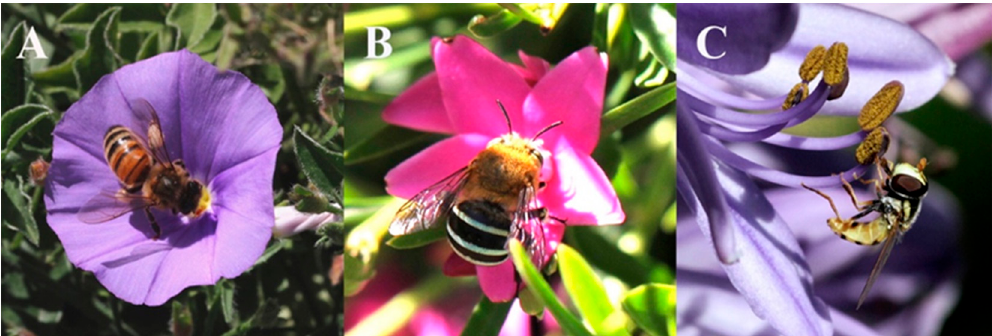
Figure 5 . Colour photographs of flower visiting insects taken nearby the pan trap locations: ( A ) honey ( A ) honey bee ( Apis mellifera ), ( B ) blue-banded bee ( Amegilla sp.), ( C ) hoverfly ( Melagyna sp.). bee ( Apis mellifera) , ( B ) blue-banded bee ( Amegilla sp.), ( C ) hoverfly ( Melagyna sp.). Images Copyright © M.S.